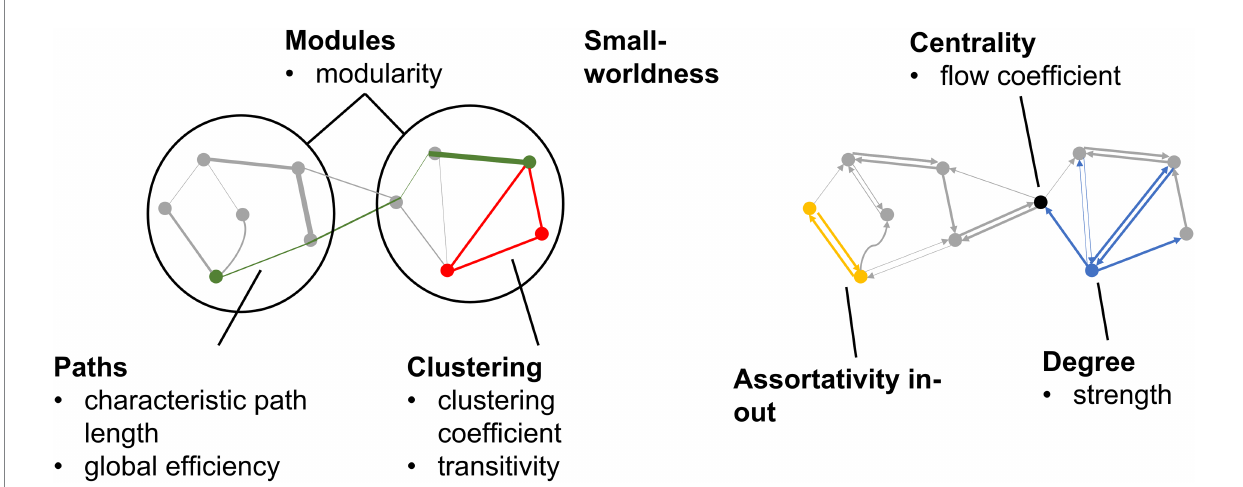
FIGURE 1 Graph metrics calculated from EC and FC graphs. Categories of graph metrics are shown in bold. Individual graph metrics within each category are